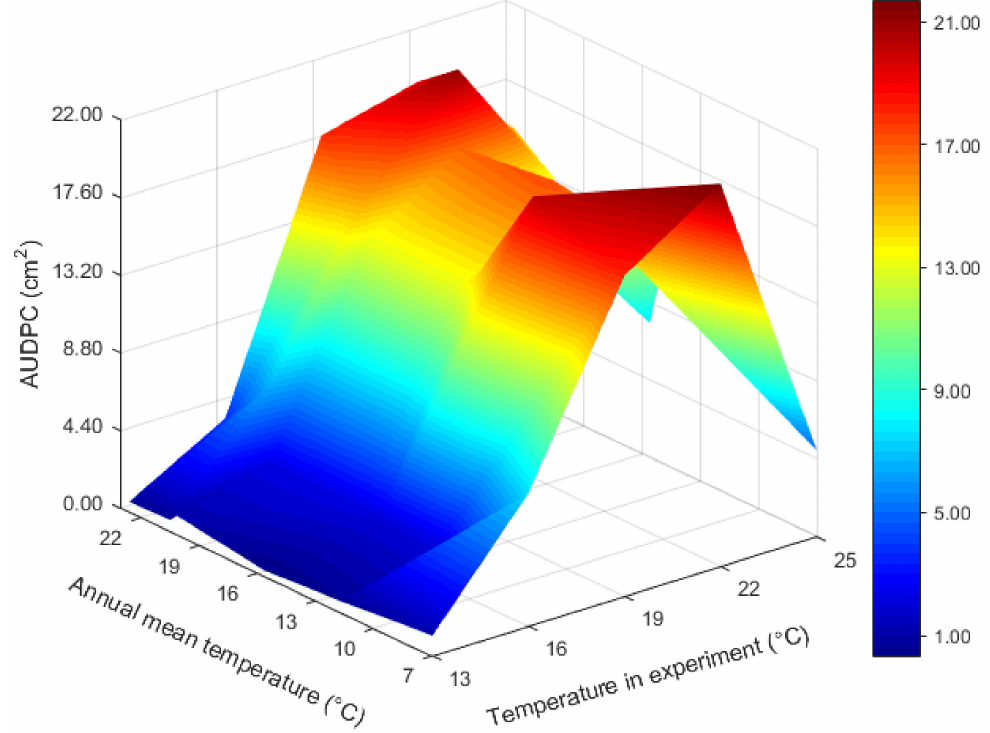
Figure 4. The interactive impact of experimental and historical temperature (i.e., the air temperature at the pathogen collection site) on the development of Phytophthora infestans aggressiveness. Pathogen aggressiveness was quantified from 140 isolates sampled from seven geographic locations in China. The aggressiveness, measured by AUDPC, was estimated from lesion size at 2–6 days post-inoculation at five experimental temperatures. NOTE: The bar color shows the change in aggressiveness value from low (blue) to high